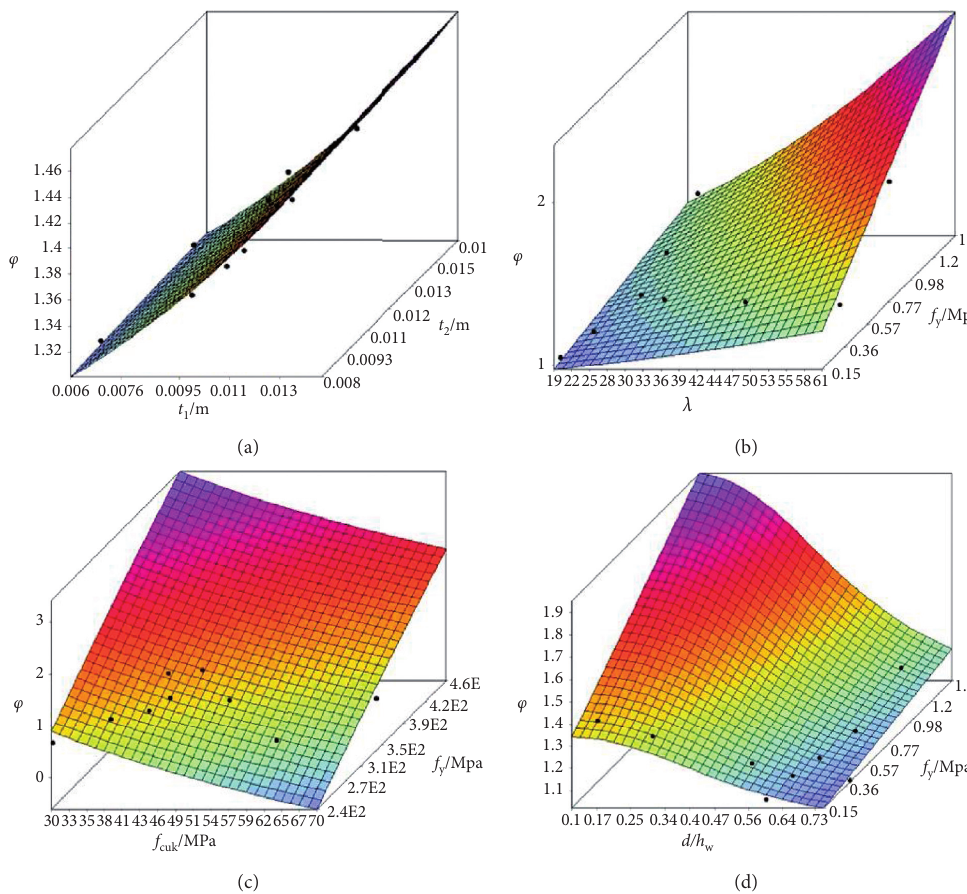
Figure 17: Effects of different parameters on φ . (a) t 1 and t 2 . (b) λ and e . (c) f cuk and f y . (d) d / h w and s / h w .